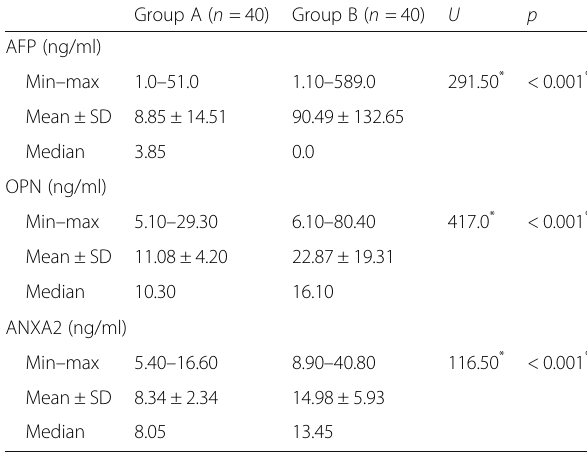
Table 2 Comparison between the two studied groups according to different tumor markers